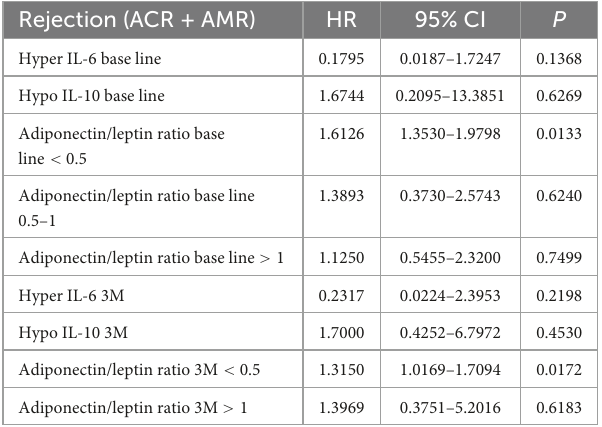
TABLE 6 Cox proportional hazard model, end point: acute rejection in protocol graft biopsy.